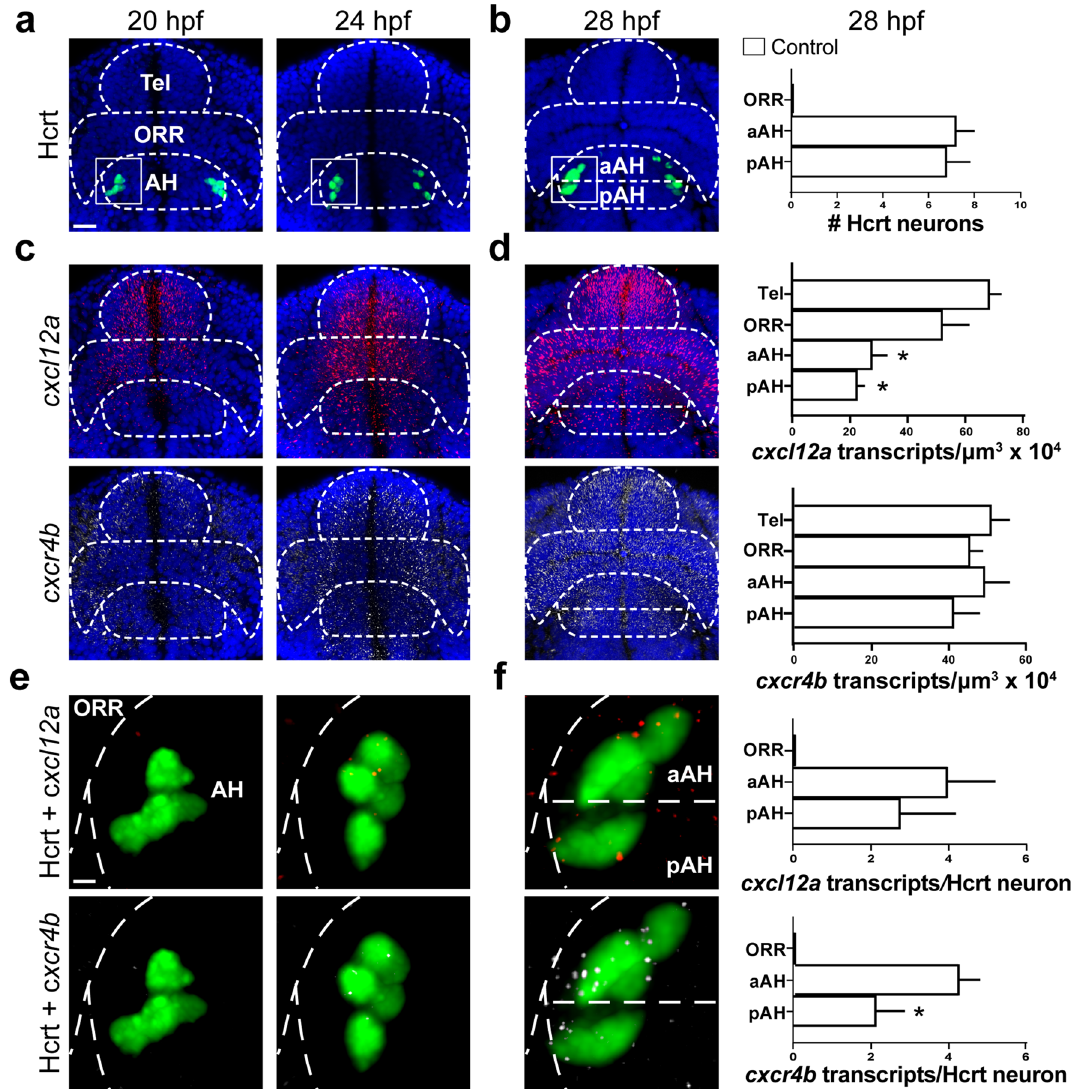
Figure 4. Embryonic development of Hcrt neurons and cxcl12a and cxcr4b transcripts under control conditions in 20, 24 and 28 hpf zebrafish brains, as evidenced by RNAscope. ( a ) Representative photomicrographs (×25) illustrate the zebrafish brain in a dorsal/ventral view with the AH, aAH, pAH, ORR and Tel of the brain outlined by dashed lines, the Hcrt neurons (green) tightly clustered together at 20 hpf while starting to spread out and increase in number at 24 hpf, and the cells counterstained with DAPI (blue). ( b ) Representative photomicrographs show Hcrt neurons (green) at 28 hpf that have migrated further anterior and become evenly distributed throughout the posterior (pAH) and anterior (aAH) parts of the AH, as shown in the bar graphs (n = 6). ( c ) Representative photomicrographs show the density of cxcl12a transcripts (red, top) and cxcr4b transcripts (white, bottom) naturally increases from 20 to 24 hpf, and the cxcl12a transcripts show a tendency to be highest in the anterior part of the brain, while the cxcr4b transcripts appear evenly distributed throughout all brain areas. ( d ) Representative photomicrographs show the cxcl12a transcripts (top) at 28 hpf as they become more dense and exhibit a natural posterior-to-anterior concentration gradient throughout the brain, with lowest levels in the pAH, moderate levels in the aAH and ORR, and highest levels in the Tel, as shown in the bar graph (n = 6). The density of cxcr4b transcripts (bottom), in contrast, is uniform across all brain regions, as shown in the bar graph (n = 6). ( e ) Enlargements of boxes at 20 hpf show no co-localization with cxcl12a (top) or cxcr4b (bottom) transcripts, while some co-localization is evident at 24 hpf. ( f ) Enlargement of boxes at 28 hpf show the cxcl12a and cxcr4b transcripts to exhibit high levels of co-localization with Hcrt neurons, with these colocalized transcripts showing dim expression. While the number of cxcl12a transcripts (top) are equally expressed in Hcrt neurons of the aAH and pAH, there is a significantly greater number of cxcr4b transcripts (bottom) in Hcrt neurons in the aAH compared to the pAH as shown in the bar graph (n = 6). Scale bar low magnification 20 µm; high magnification 8 µm. * p < 0.05 compared to Tel. Results are shown as means ± standard errors. AH anterior hypothalamus, aAH anterior part of the anterior hypothalamus, pAH posterior part of the